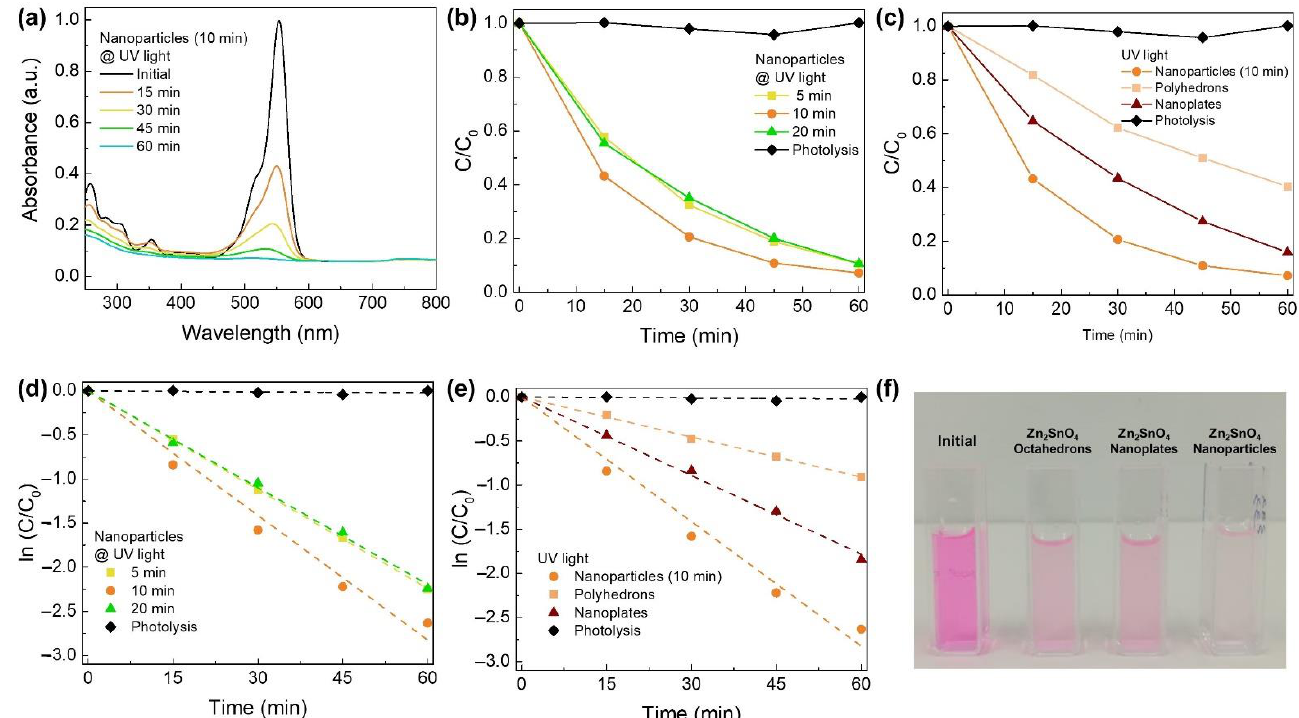
Figure 4. ( a ) Absorbance spectra of the RhB photocatalytic degradation under UV light using as photocatalyst Zn 2 SnO 4 nanoparticles (10 min synthesis time). C/C 0 comparison of the RhB photo- catalytic degradation ( b ) between ZTO nanoparticles (5, 10, and 20 min synthesis time) and ( c ) be-